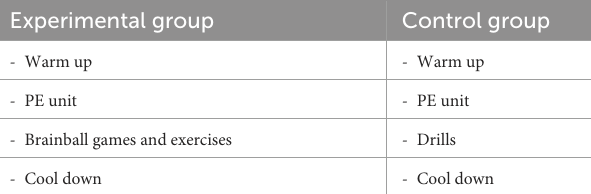
TABLE 1 Physical education of experimental and control